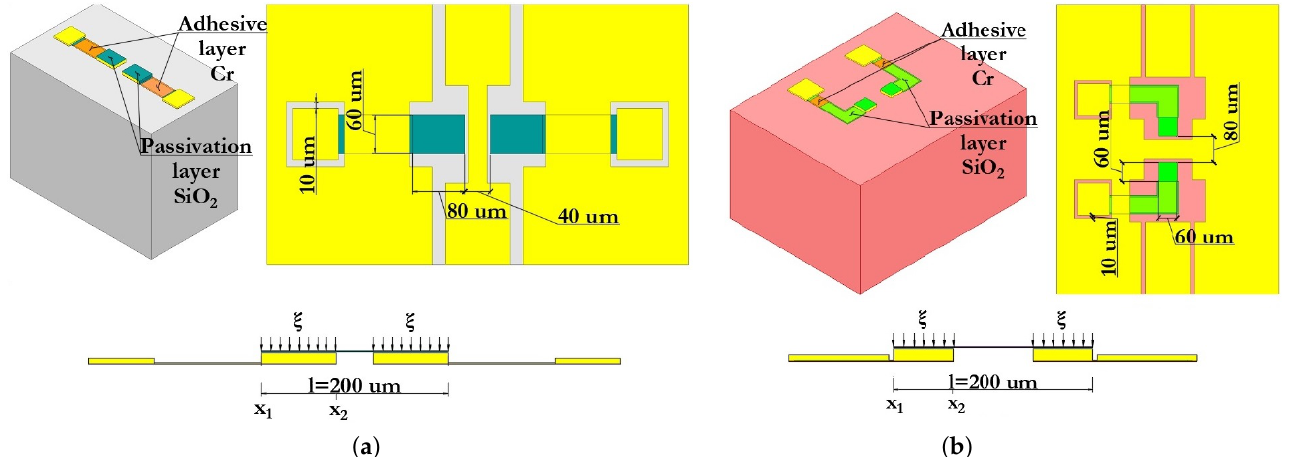
Figure 14. Schematic view of the structures of the fixed down actuation electrodes: ( a ) switch (A); ( b ) switch